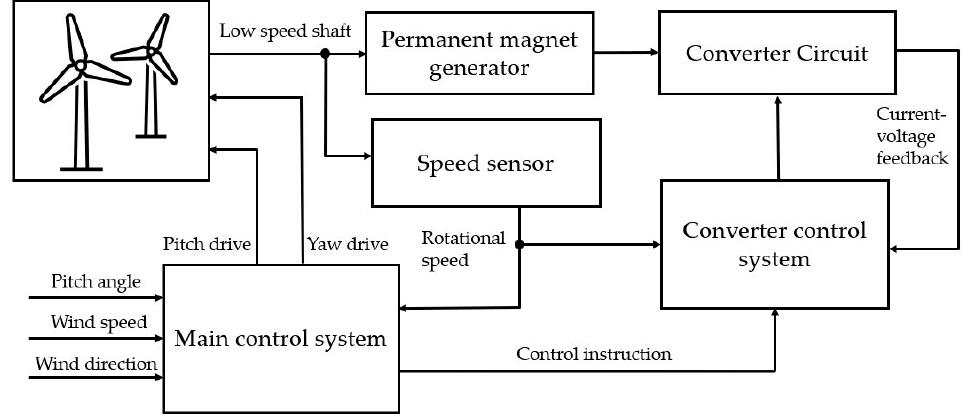
Figure 15. Schematic diagram of direct drive permanent magnet wind turbine